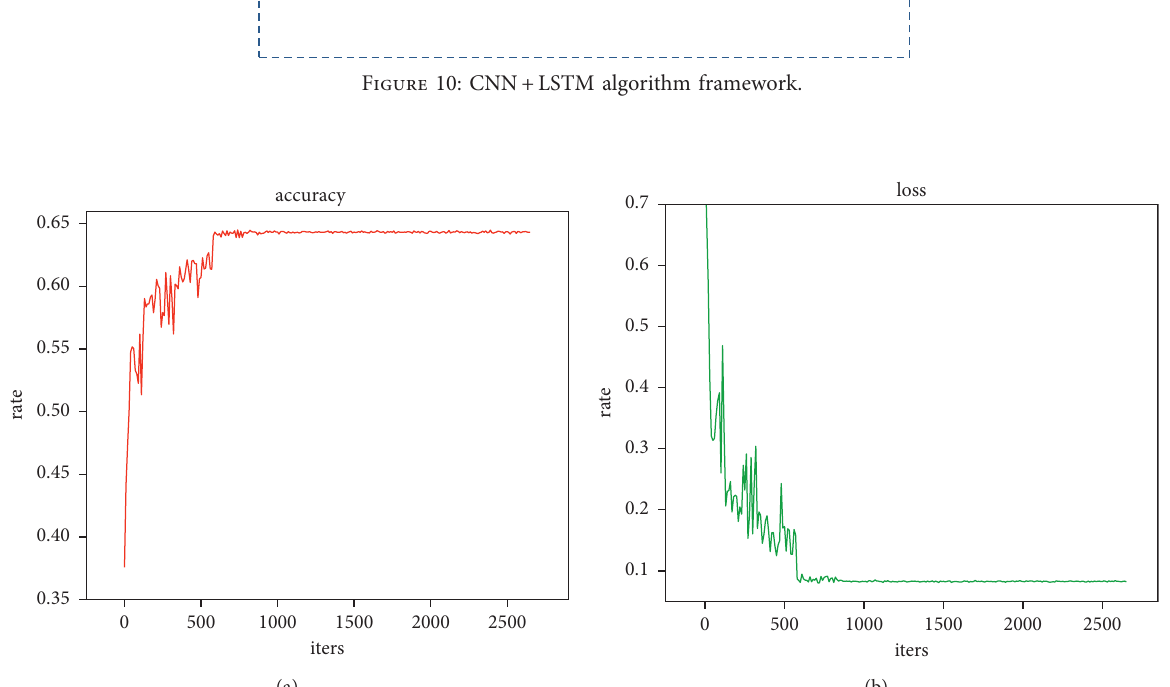
Figure 11: (a) Accuracy of CNN +LSTM under CASME II, (b) loss function of the training